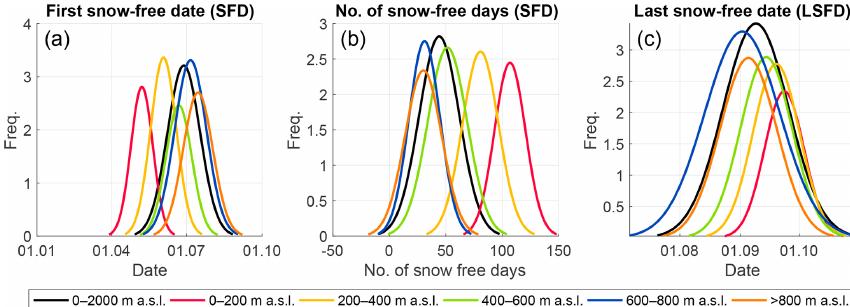
Figure 10. Normal distributions for extracted first snow-free date, number of snow-free days and last snow-free